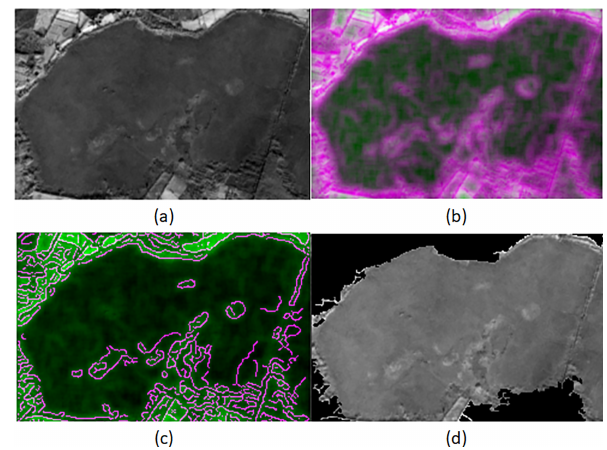
Figure 4. (a) Original Clara Image (b) Entropy Filter Image (c) Canny Edge Image (d) Boundary Delineated Image.